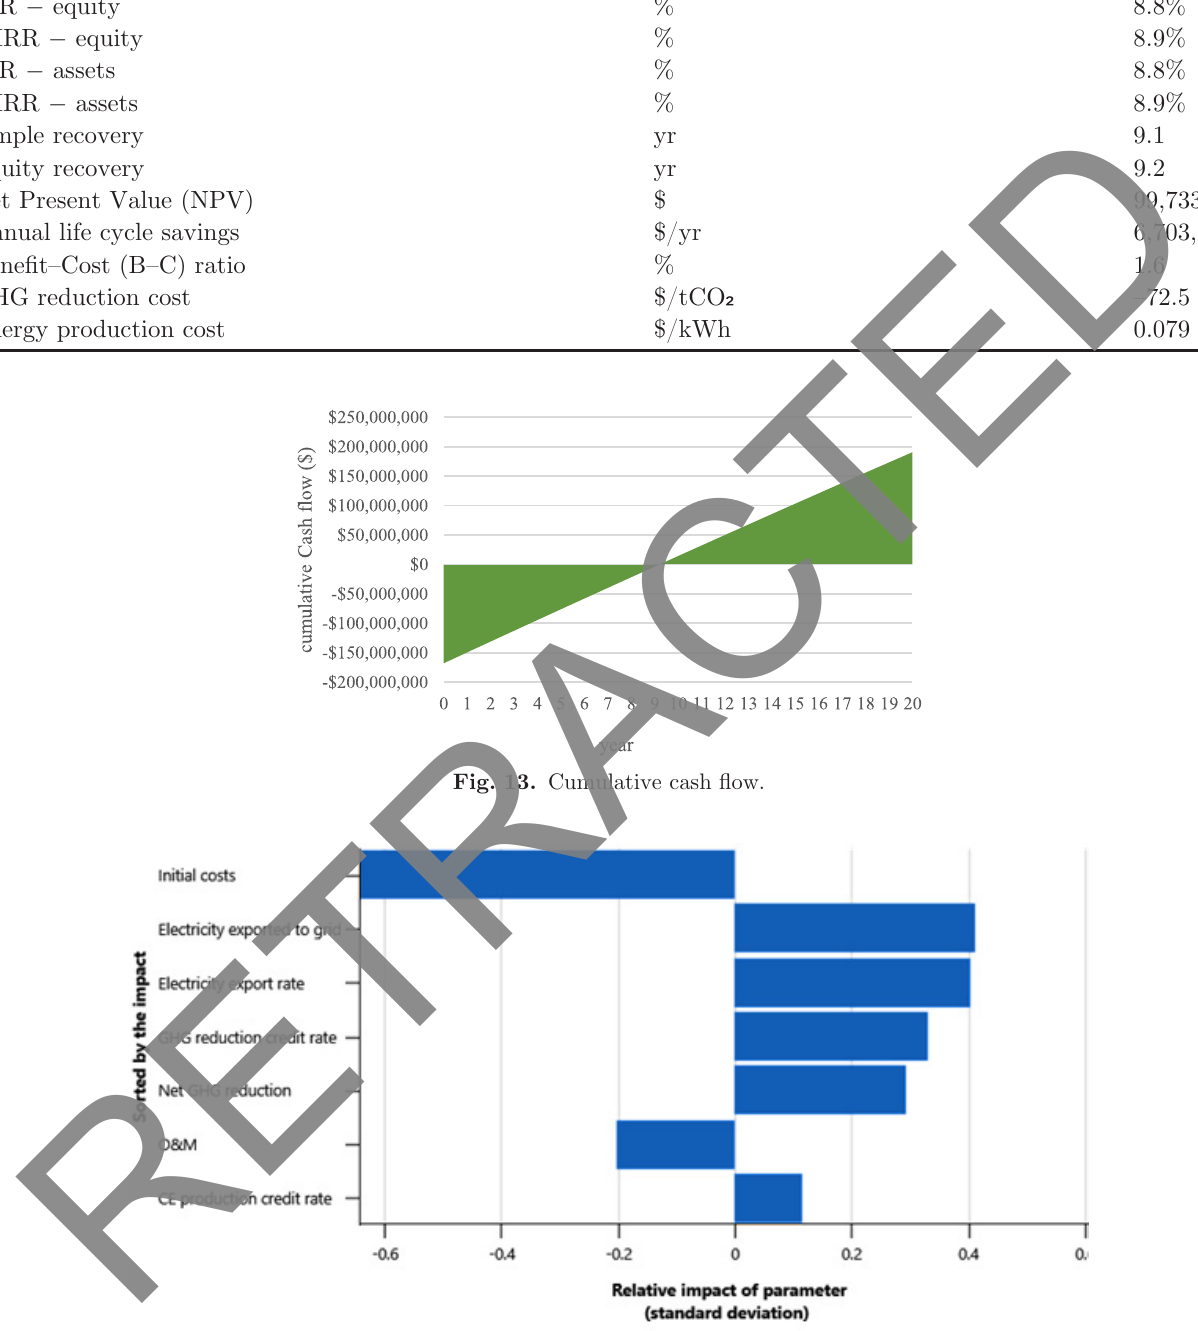
Table 7. Financial Viability analysis of the wind farm.